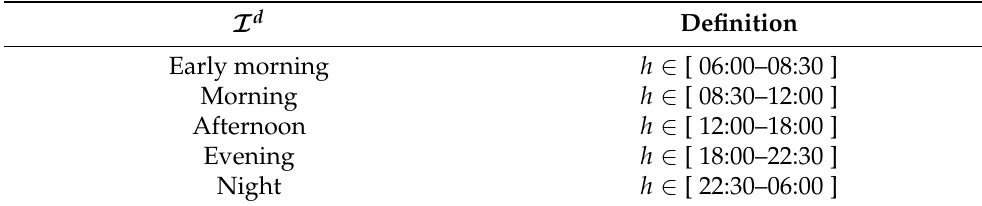
Table 3. Definition of the considered time periods I d at the daily level, based on the hour of the day, h